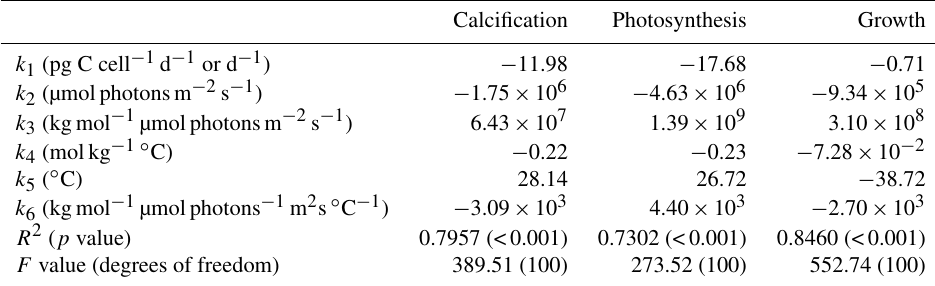
Table 1. Fit coefficients ( k 1 to k 6 ), R 2 , F values, degrees of freedom and p values obtained for calcification (pgC cell − 1 d − 1 ), photosynthetic carbon fixation (pgC cell − 1 d − 1 ) and growth rates (d − 1 ) from Eq. (2) fitted to data from this study and Sett et al. (2014). For calcification and photosynthetic carbon fixation rates, the unit for v is pgC cell − 1 d − 1 , while for growth rates, the unit for v is d − 1 .